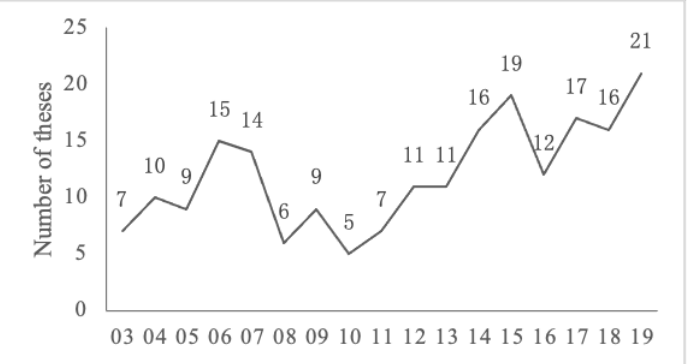
Figure 1. Annual distribution of the numbers of master’s theses in theology.